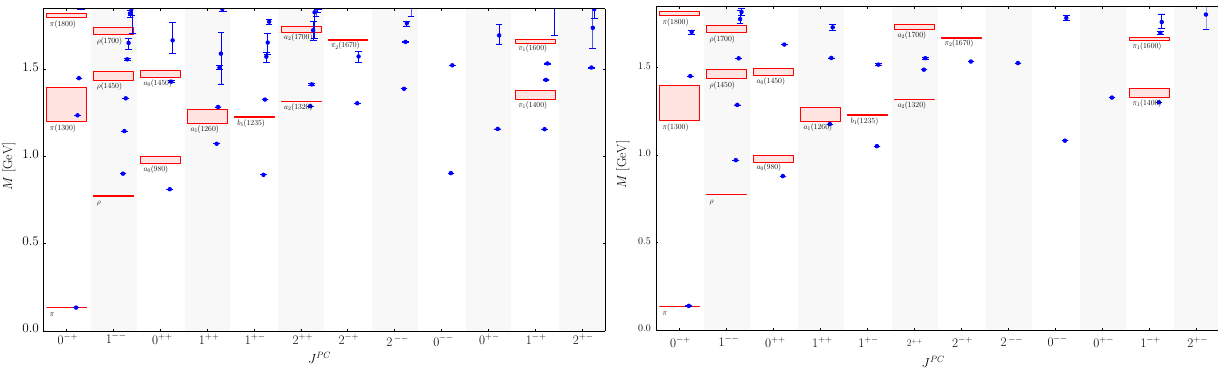
Fig. 5 Light isovector quarkonium spectra of mesons with J ≤ 2 including exotic quantum numbers, fitted to all listed splittings (left) and a combination of the reduced sets only (right). Calculated values (blue circles) are compared to experimental data (red boxes) from